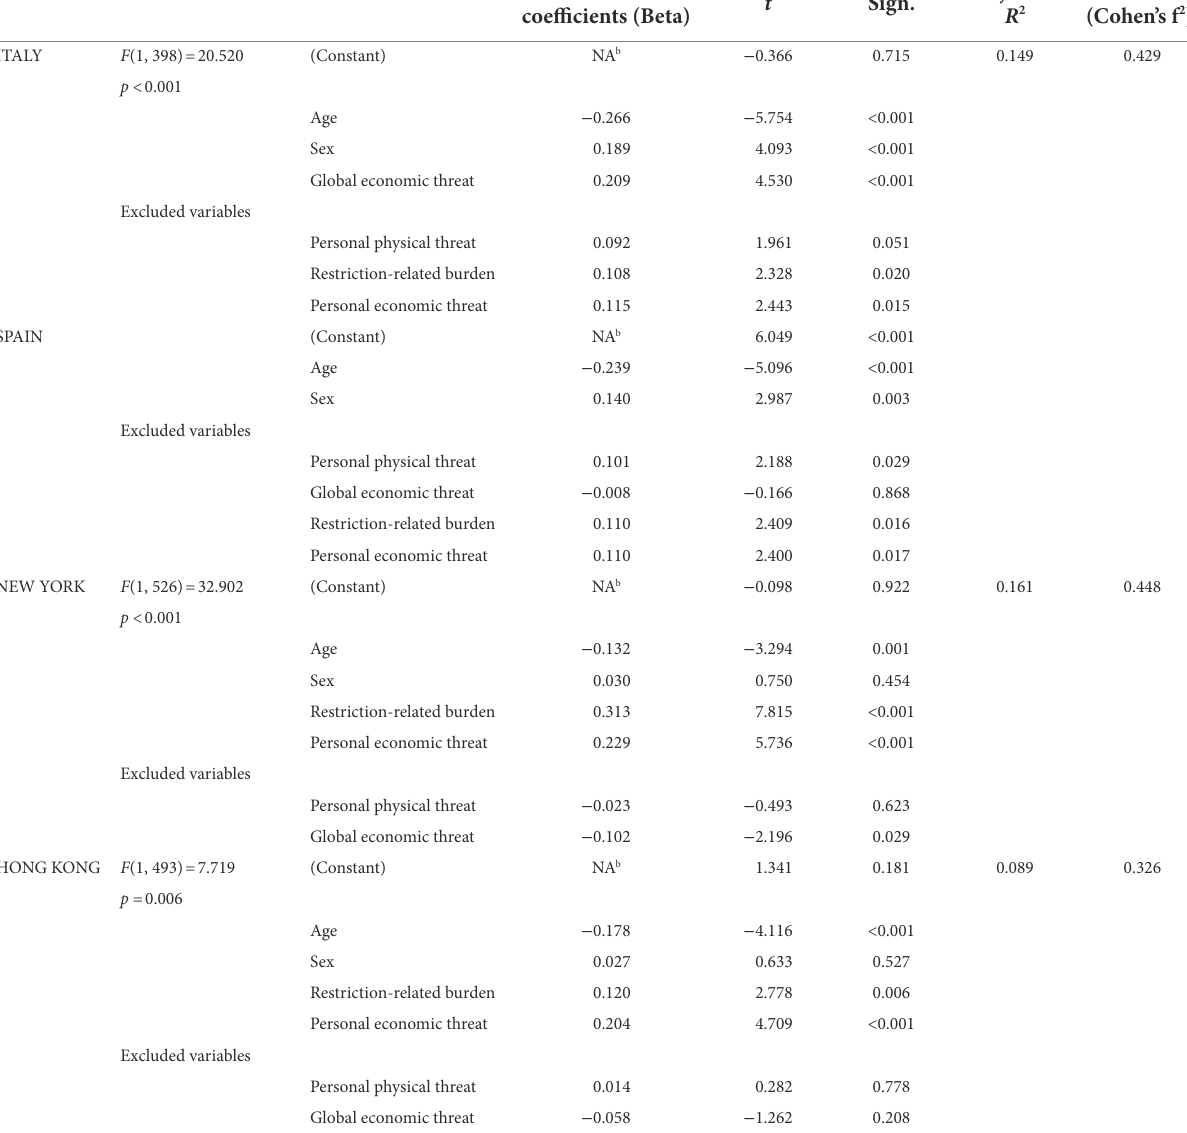
TABLE 7 Hierarchical multiple regression models a